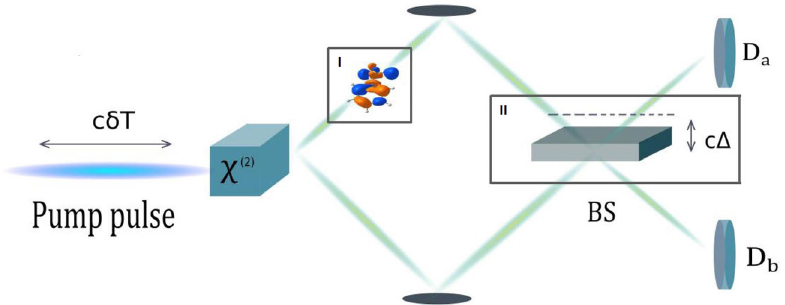
Fig. 1 Interferometric spectroscopy setup. Hong-Ou-Mandel interferometer. A pump beam propagates through a χ (2) nonlinear crystal. The interaction between fi eld modes mediated through the crystal induces entanglement between two well separated beams of different polarization produced by spontaneous parametric down conversion. One beam interacts with a sample (inset I), while the other propagates in an empty arm. The two beams are fi nally combined on a beamsplitter (BS) (inset II), and collected in two detectors D a and D b . Insets I and II are speci fi ed in more detail in Figs. 3 and 4,